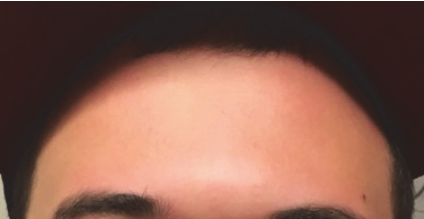
Figure 1: Bilateral loss of forehead creases while attempting to elevate the eyebrows.